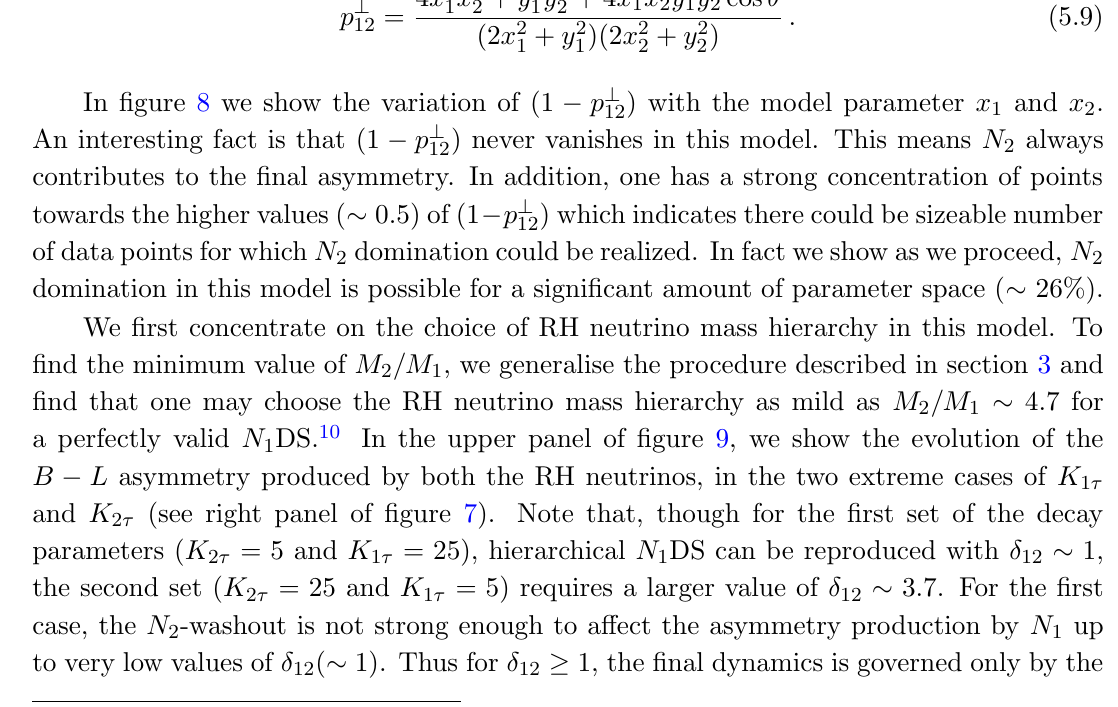
Figure 8 . Plot showing the quantity (1 asymmetry generated by N 2 is proportional to (1 model, a pure N 1 dominated scenario is not possible. Note that x 1 ; 2 are dimensional quantities, and are plotted in units of p